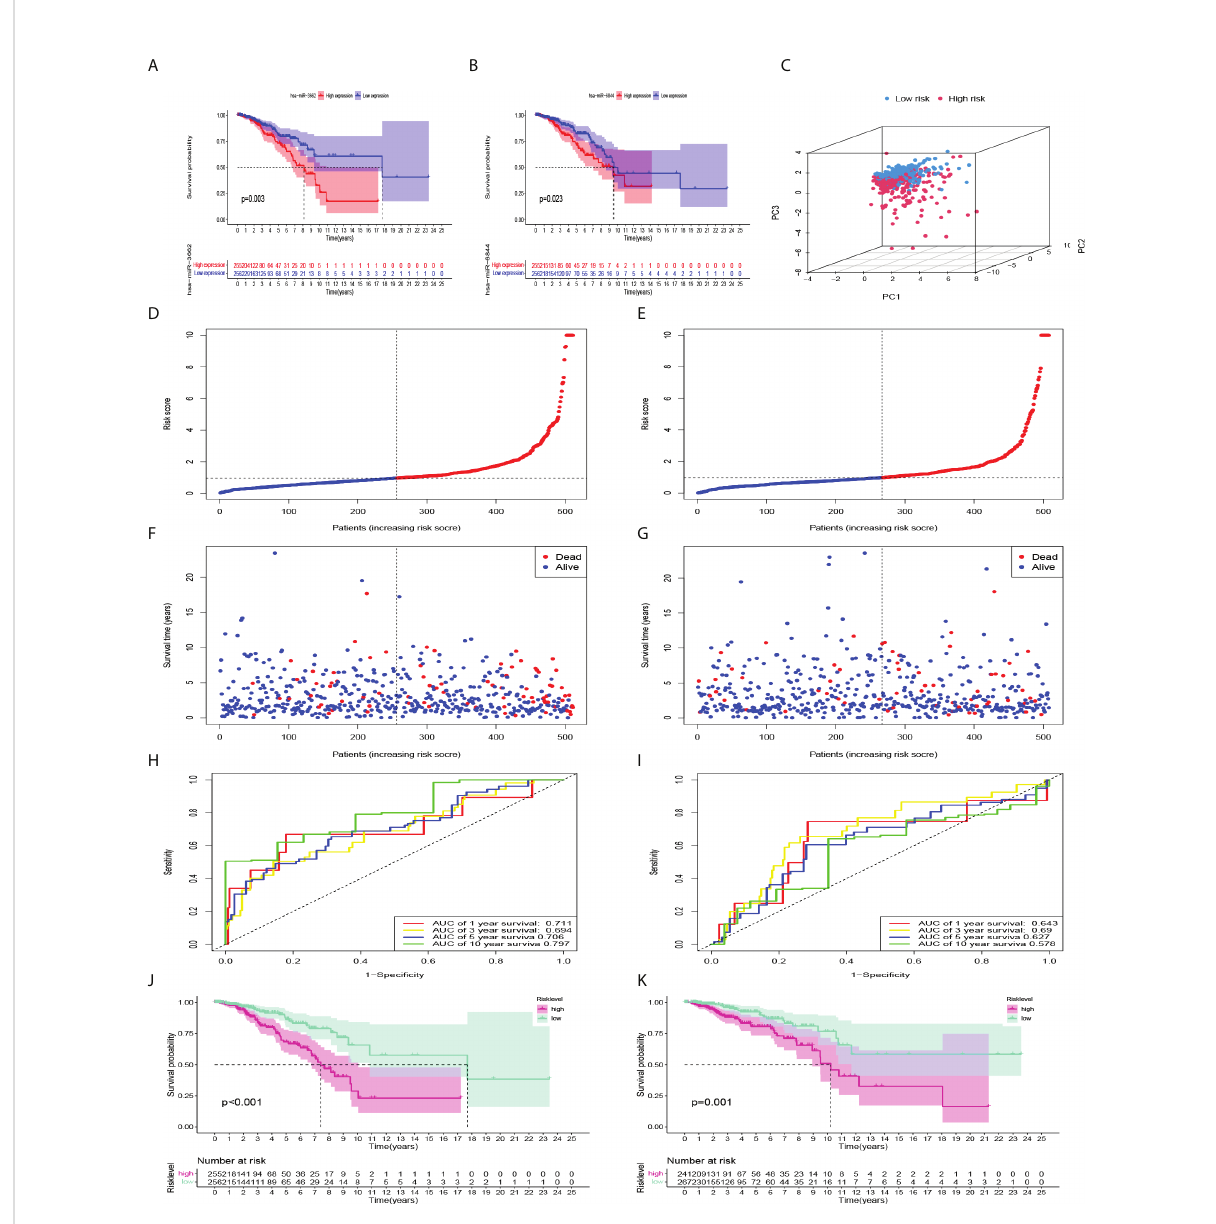
FIGURE 4 Internal veri fi cation and predictive ef fi ciency of the Cox model consisting of 12 miRNAs. (A, B) Kaplan-Meier curves showed that high expression of miR-3662 and miR-6844 were signi fi cantly correlated with a poor prognosis. (C) PCA of the model. (D, F) Risk factor association map was made for each BC patient in train set, and (E, G) in validation set. (H, J) ROC curve and Kaplan-Meier curves of the model in train set, and (I, K) in validation